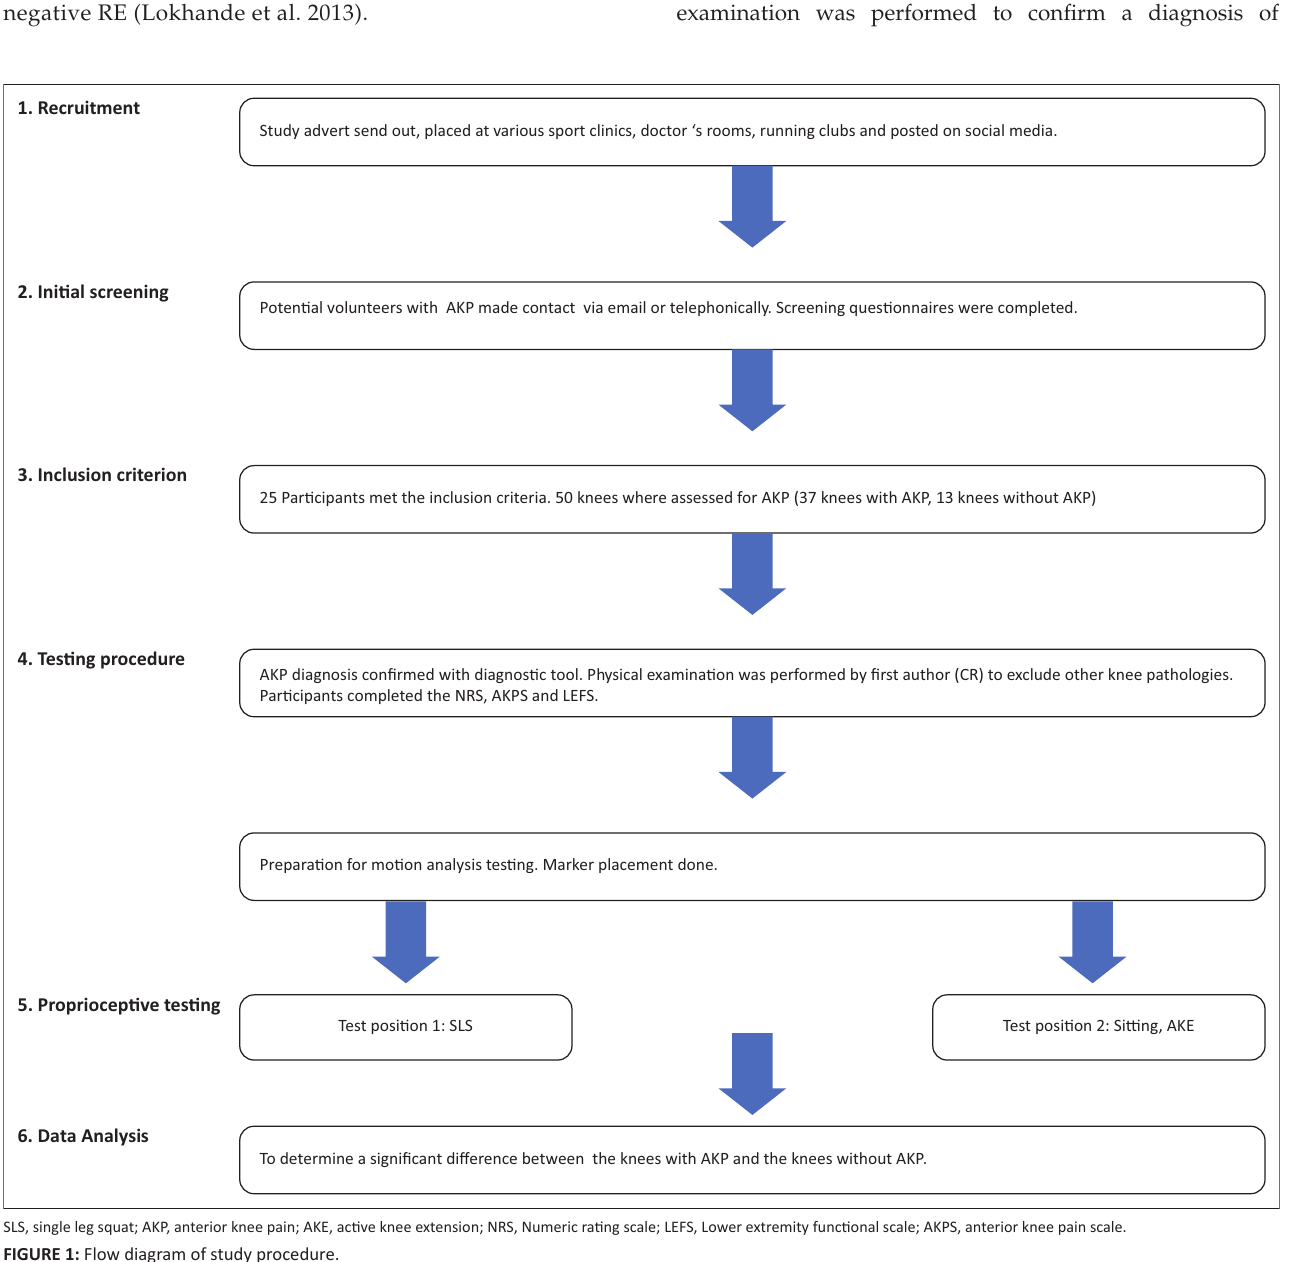
FIGURE 1: Flow diagram of study